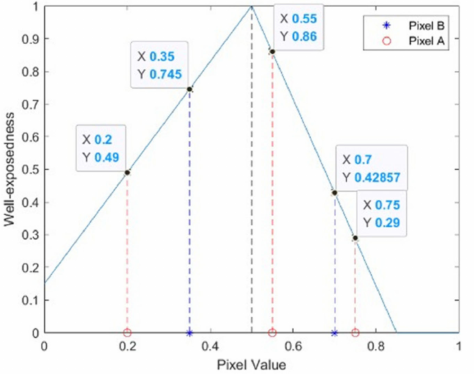
Figure 4. Exposure rates of Pixel A and B of